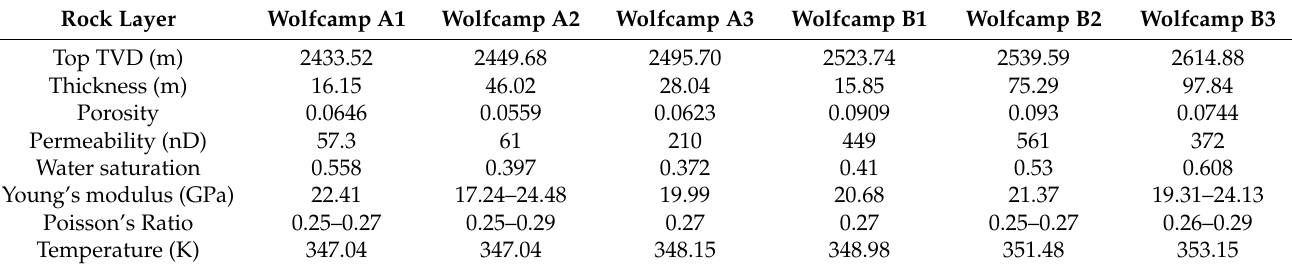
Table 2. Layer properties of the Wolfcamp shale in the Permian Basin [35,36].